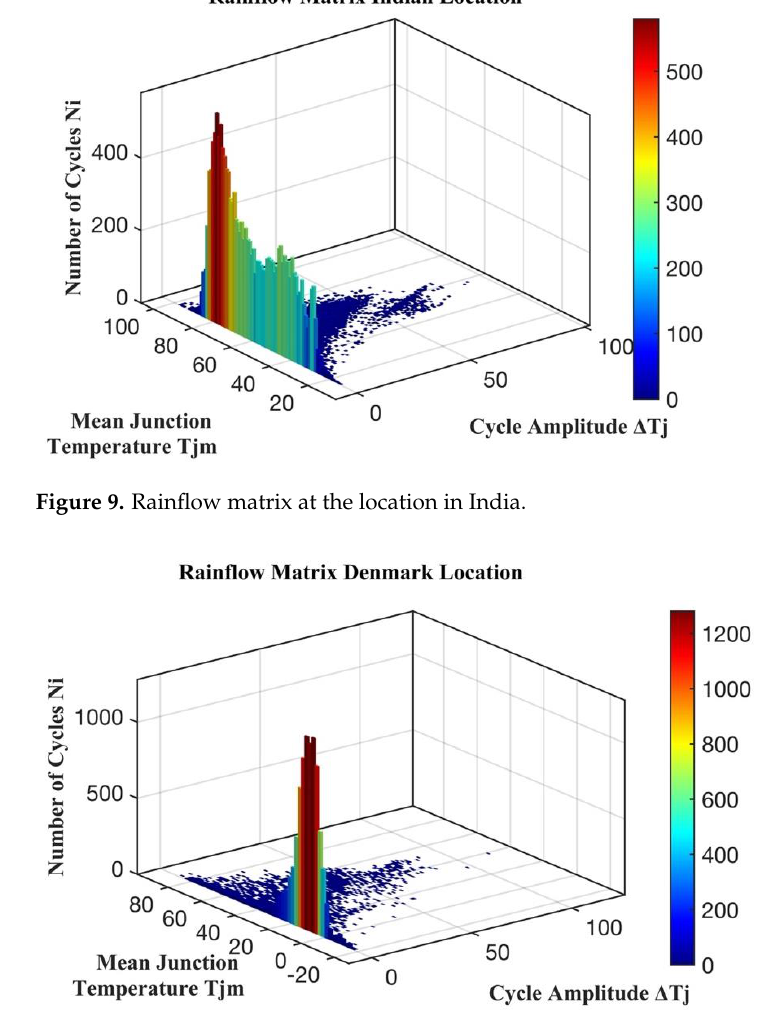
Figure 8. One-year estimated junction temperatures at the location in Denmark.